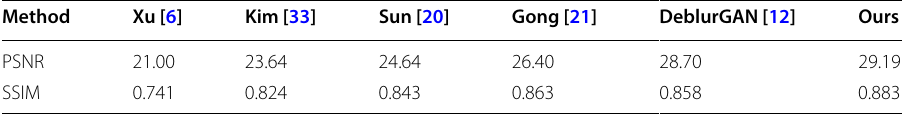
Table 2 Performance comparison on the GOPRO dataset